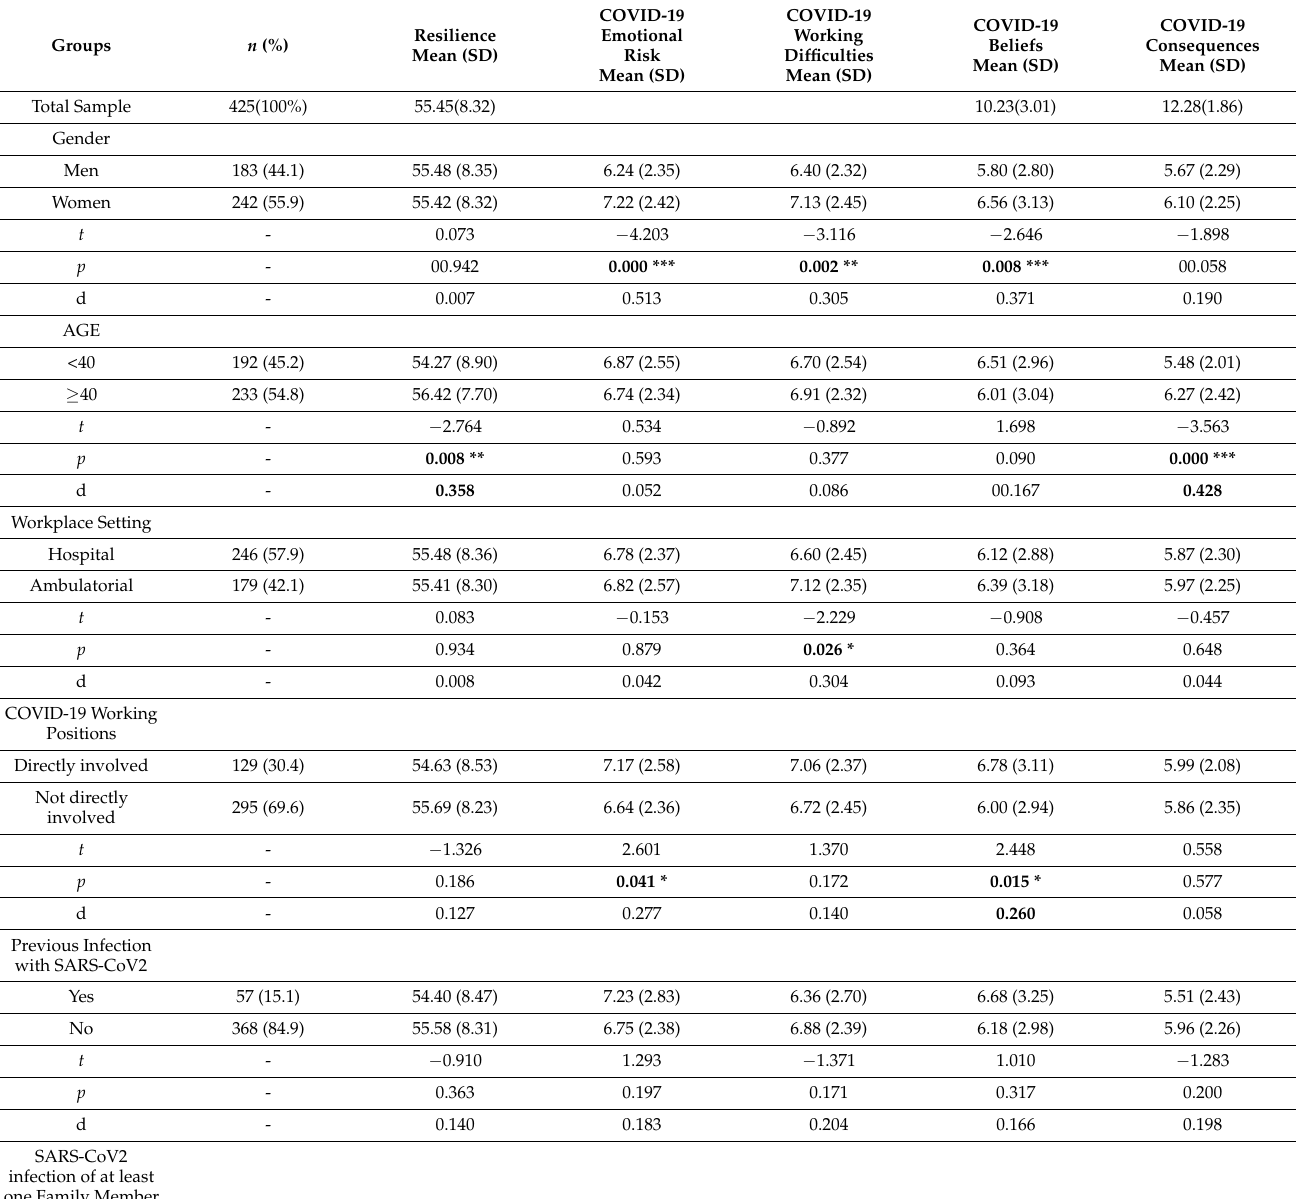
Table 5. Differences between Groups (Student’s t -Test, ANOVA One Way). Psychological Variables: Resilience; COVID-19 Risk Factors: Emotional (Working Risk, Working Difficulties), and Fear of COVID-19 (COVID-19 Beliefs, COVID-19